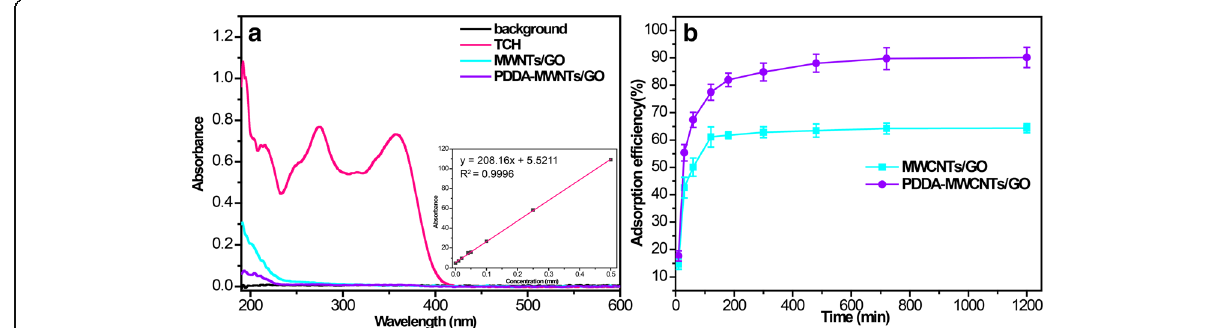
Fig. 6 a UV/Vis absorption spectra of the initial TCH solution and the residue solutions obtained by filtration using MWCNTs/GO and PDDA-MWCNTs/GO membranes. The insert picture is the standard curve of concentration of TCH (10 μ M, 20 μ M, 40 μ M, 50 μ M, 100 μ M, 250 μ M, 500 μ M). b The static adsorption of TCH